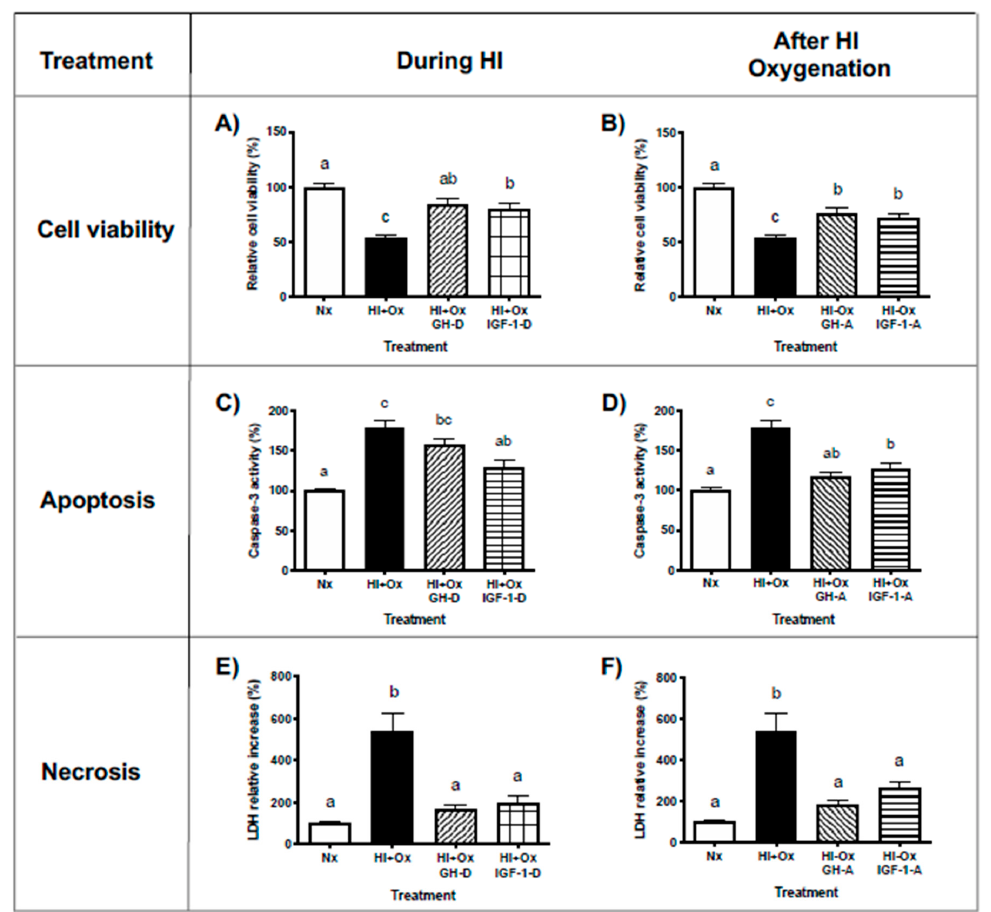
Figure 3. Effects of GH or IGF-1 treatments upon cell viability, apoptosis, and necrosis in primary cerebellar cultures exposed to Nx, HI, or HI + Ox incubation conditions. The hormones (1 nM GH or 40 nM IGF-1) were administered either during (denoted by D) the acute 12 h injury phase (HI, panels ( A , C , E )) or after it (denoted by A); this occurred in the subacute phase in the reoxygenation 24 h period (HI + Ox, panels ( B , D , F )). Panels ( A , B ) show the analysis of cell viability as determined by the MTT assay. Panels ( C,D ) show the evaluation of apoptosis, measuring caspase-3 activity. Panels ( E , F ) show cell necrosis, as determined by LDH activity released to the culture media. Values are reported as percentage change in relation with the normoxic (Nx) control groups (100%). Both hormones were capable of recovering cell viability (panels ( A , B )) and decreasing cell necrosis (panels ( E , F )) when administered either during the acute injury phase (HI + Ox GH-D; HI + Ox IGF-1-D) or in the reoxygenation period (HI + Ox GH-A; HI + Ox IGF-1-A). On the other hand, IGF-1 treatment substantially reduced caspase-3 activity in both conditions (panels ( C , D )), whereas GH treatment was only effective when added in the subacute injury phase (HI + Ox GH-A). Bars represent the mean ± SEM, n = 5 independent experiments performed in triplicate. Groups with different letters are significantly different by one-way ANOVA and Tukey’s post hoc test (p <